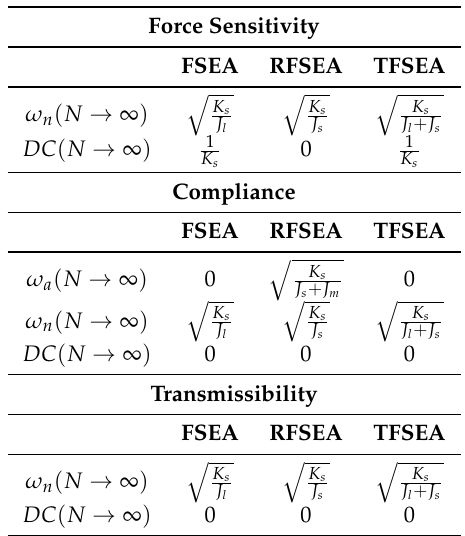
Table 8. Resonance frequency and DC gain of SEA criteria with high gear